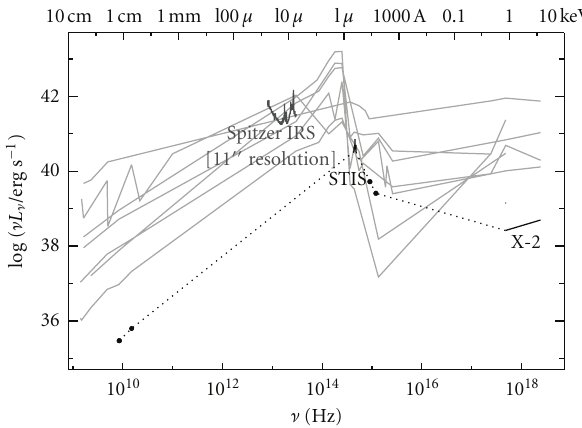
Figure 4: Radio to X-ray nuclear SED of NGC 4736 superposed on SEDs of LLAGN from Ho [47]. The optical STIS spectrum stands out as an amorphous blob featuring the strong H α emission feature. The 2–10 keV Chandra X-ray detection X2 is depicted as a power- law corresponding to Γ = 1 . 6. The low spatial resolution Spitzer IRS observations are shown for comparison.